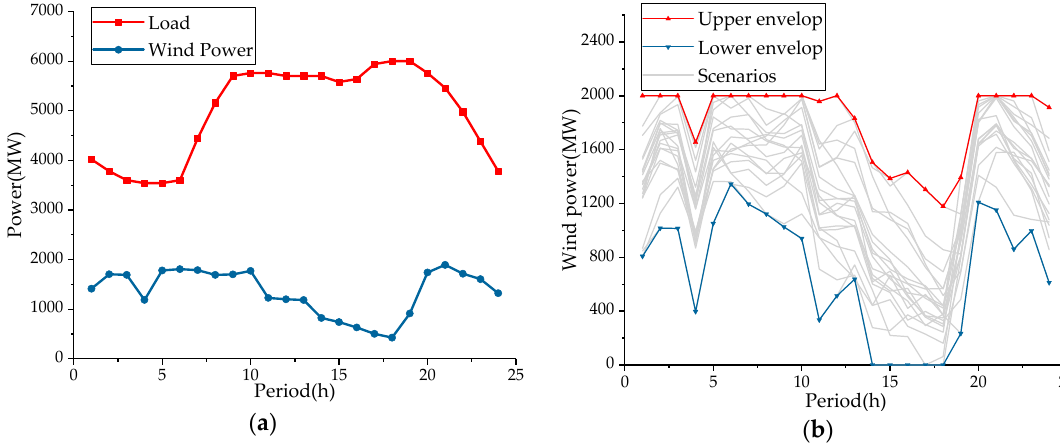
Figure 2. Load and wind power: ( a ) Predicted load and wind power; ( b ) Representation of wind uncertainty over time.